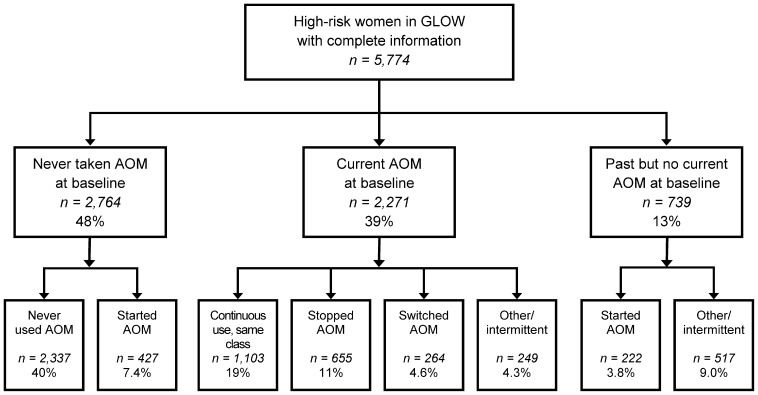
Patient flow chart.